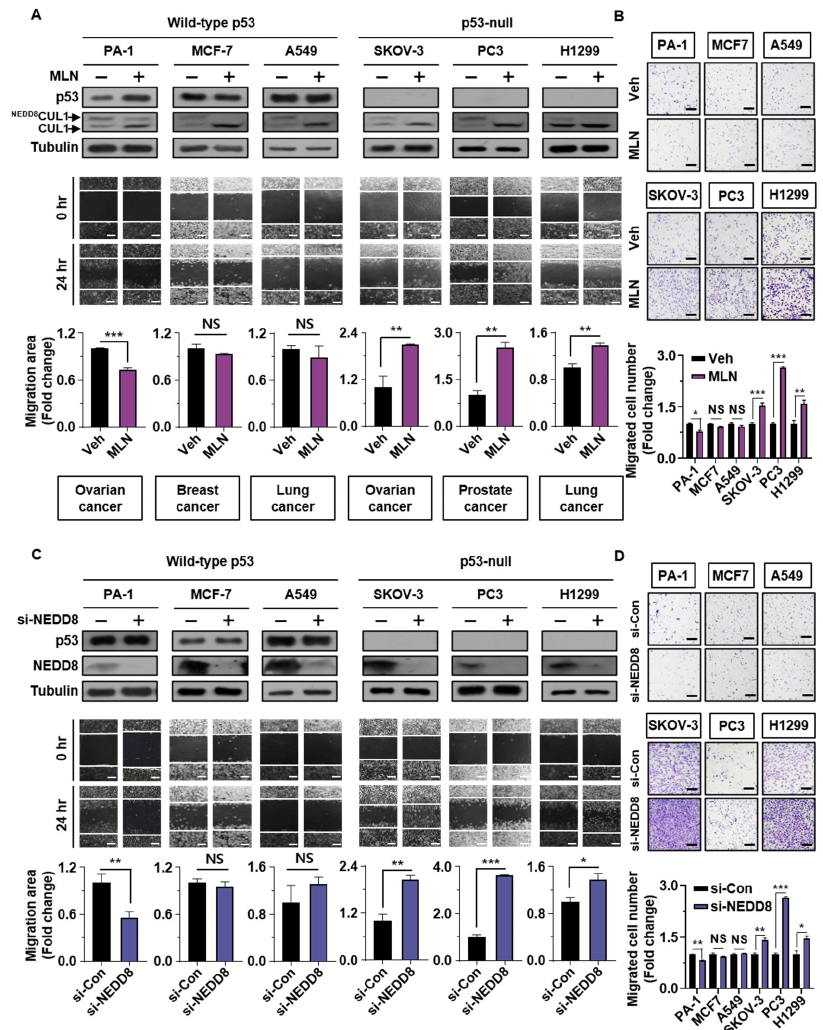
Figure 1. Neddylation blockade induces cancer cell migration according to p53 status. ( A , C ) Wild type p53 (PA-1, MCF-7, and A549) and p53-null (SKOV-3, PC3, and H1299) cancer cell lines were subjected to wound healing assays with or without MLN4924 (125 nM) for 24 h or were transfected with si-Control or si-NEDD8 and analyzed by Western blotting. Scale bar: 200 μ m. Whole areas were measured using ImageJ software. The upper band of CUL1 indicates neddylated CUL1, and the lower band indicates CUL1. ( B , D ) Cancer cells treated with or without MLN4924 (125 nM) for 24 h or transfected with si-Control or si-NEDD8 were subjected to Transwell assays. The number of cells in four randomly chosen fields was counted. Data are presented as the means ± standard deviation ( n = 3). * p < 0.05; ** p < 0.01; *** p < 0.001; NS, not significant.